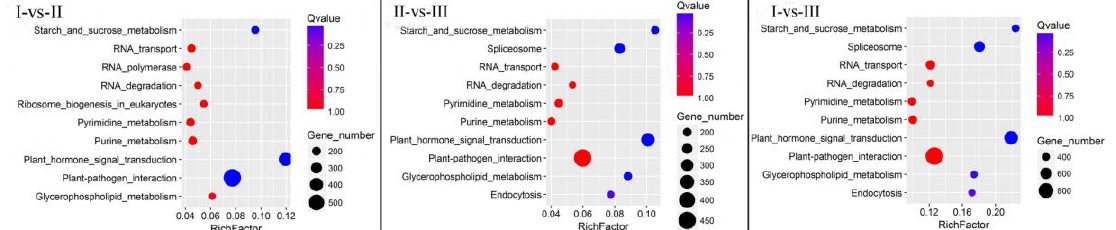
Figure 5. Distribution of Chinese chestnut kernel differentially expression genes (DEGs) in Kyoto Encyclopedia of Genes and Genomes (KEGG) pathways. (Note: The abscissa shows the enrichment factor, and the ordinate shows the KEGG pathway).